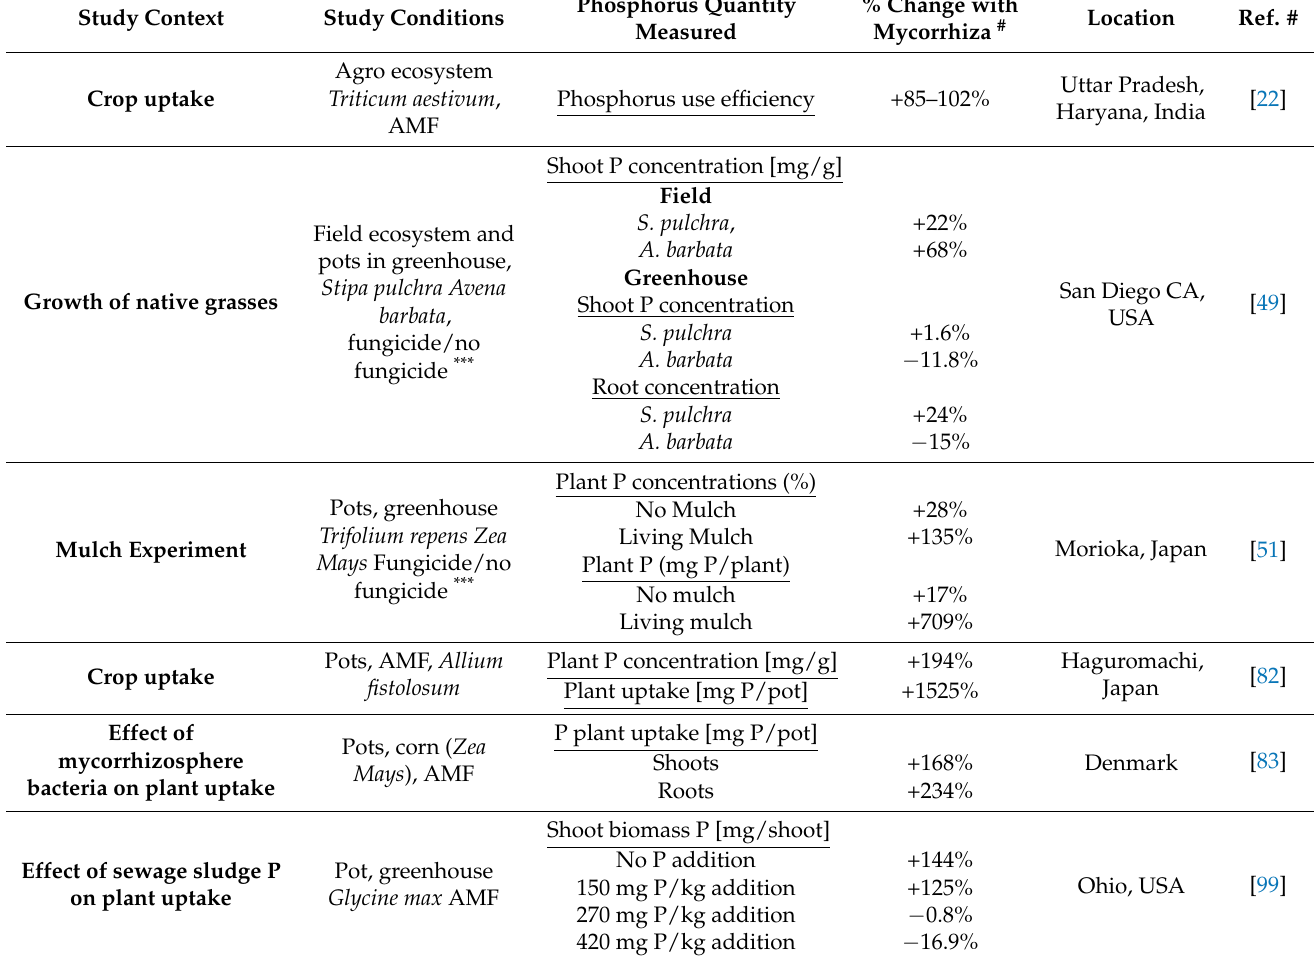
Table 1. The effect of mycorrhizae on plant uptake, leaching and soil P from studies carried out under different experimental conditions and with different objectives. Underscored show the physical quantity